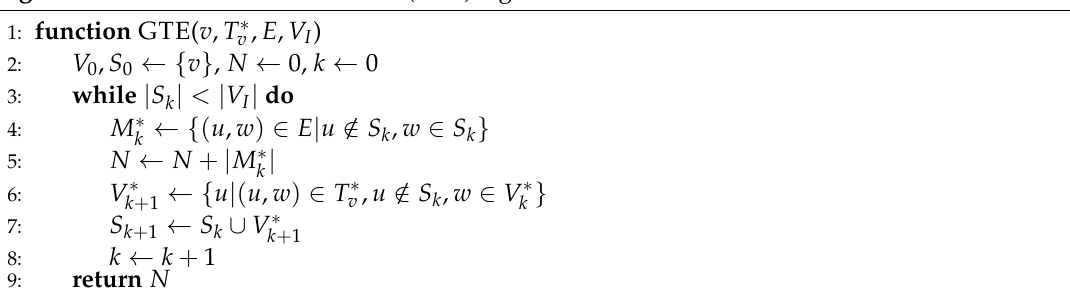
Algorithm 2 Growth-Tree Estimation (GTE)